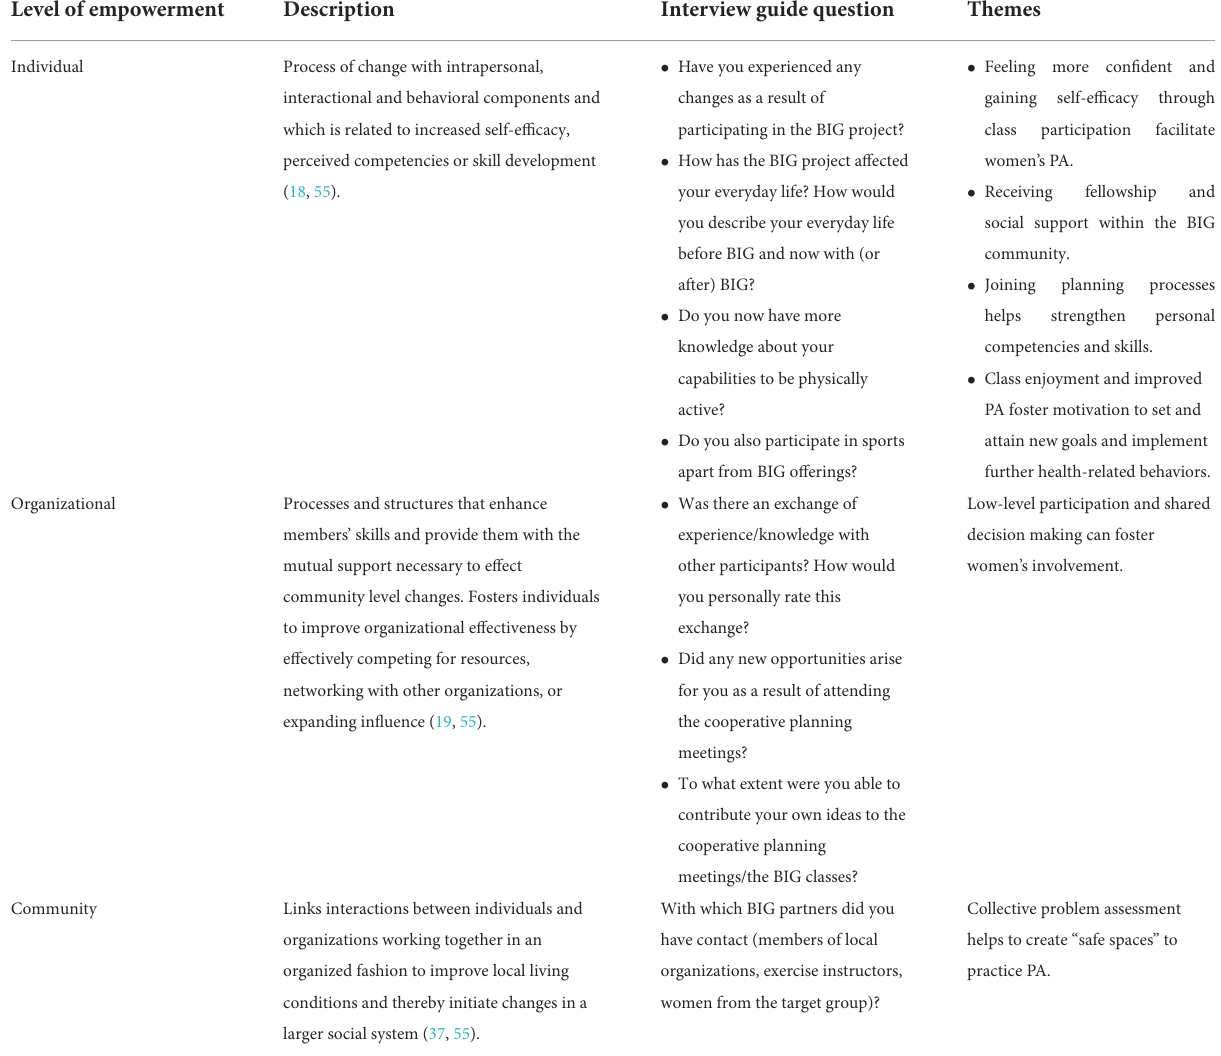
TABLE 2 Framework showing themes based on empowerment